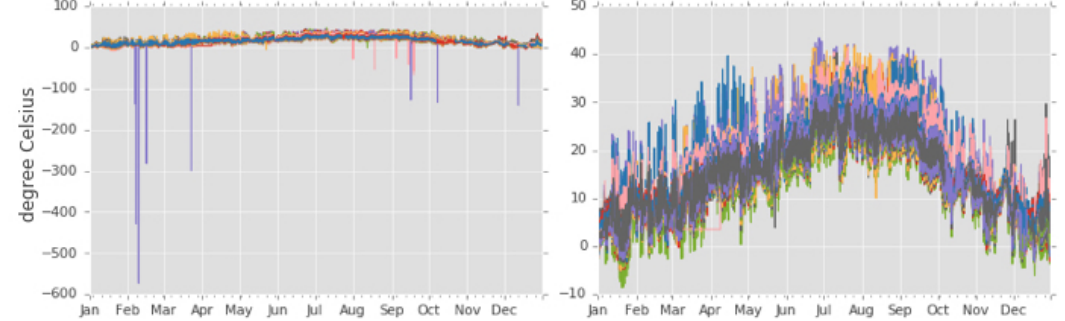
Figure 4. Example of temperature time series for the Year 2016 from Weather Underground stations in Milan before ( left ) and after ( right ) the cleaning and smoothing procedures. Coarse outliers ( left ) are clearly removed from the data set ( right